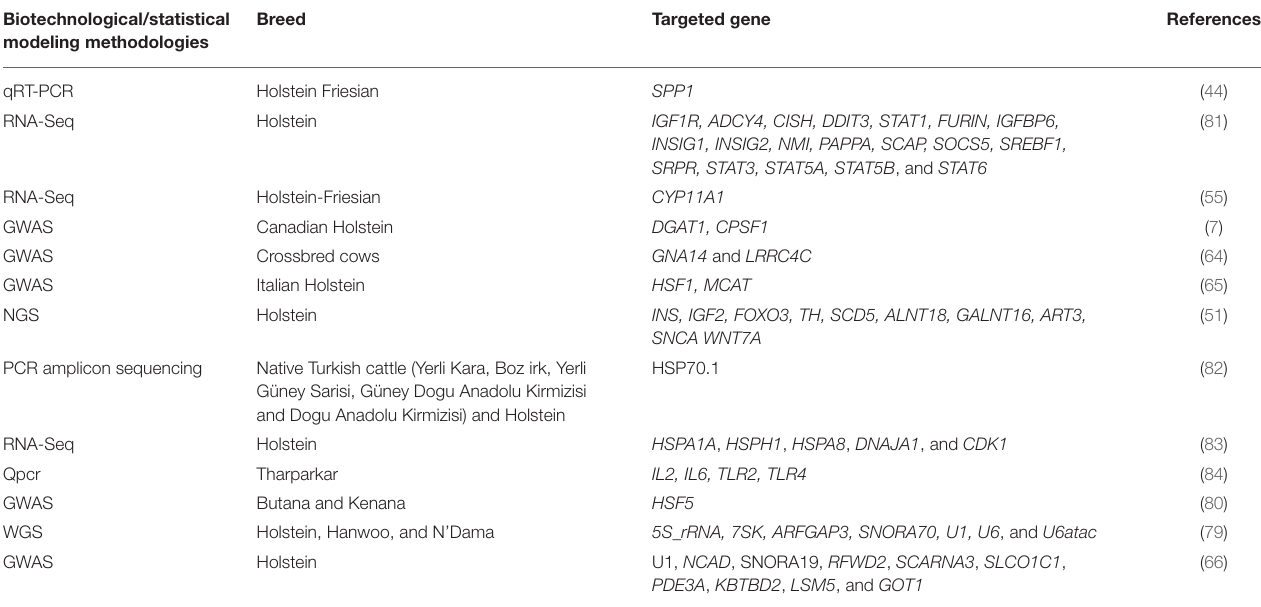
TABLE 2 | Biotechnological and statistical modeling methodologies to identify different genes associated with climate resilience capacity in dairy cattle. Biotechnological/statistical modeling